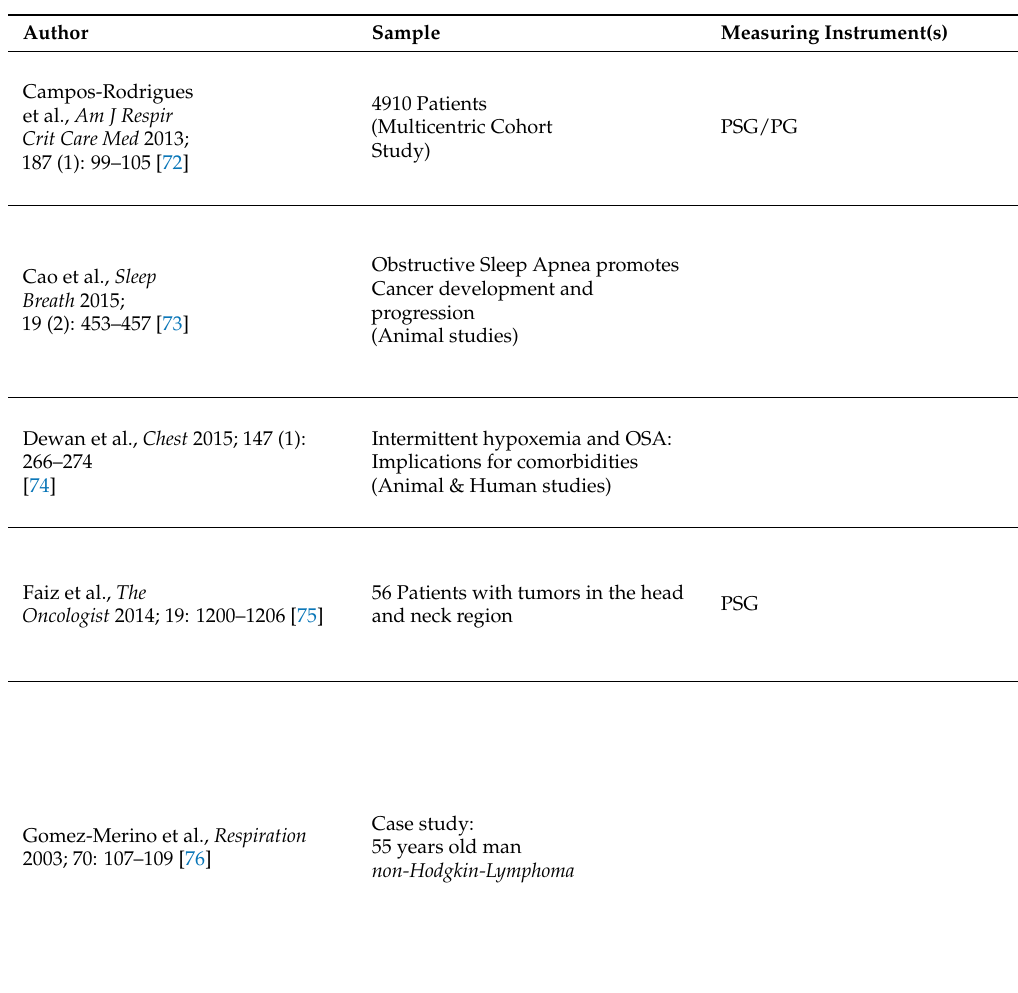
Table 6. Studies on Sleep-Related Breathing Disorder (SRBD)/Obstructive Sleep Apnea Syndrome (OSAS) in